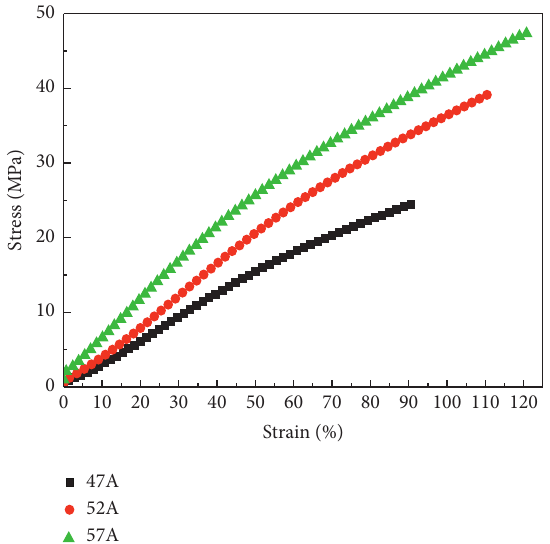
Figure 9: Quasistatic tensile stress-strain curves of PVC elastomers with three types of Shore